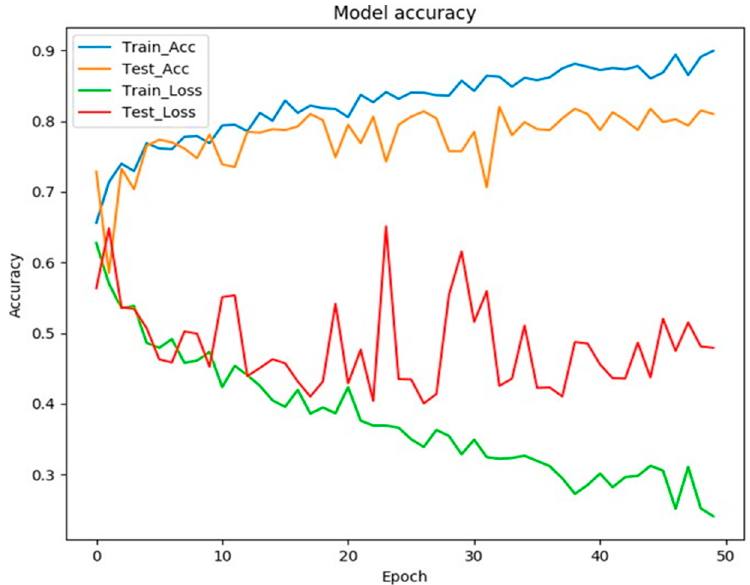
Figure 5. Accuracy and error during CNN training to predict high- and low-quality images. Note that around the 20th epoch, the accuracy of the model in the test group continued to rise, and at validation, it stabilized. The error curve also did not follow the decline. the image with eosin subtraction (H